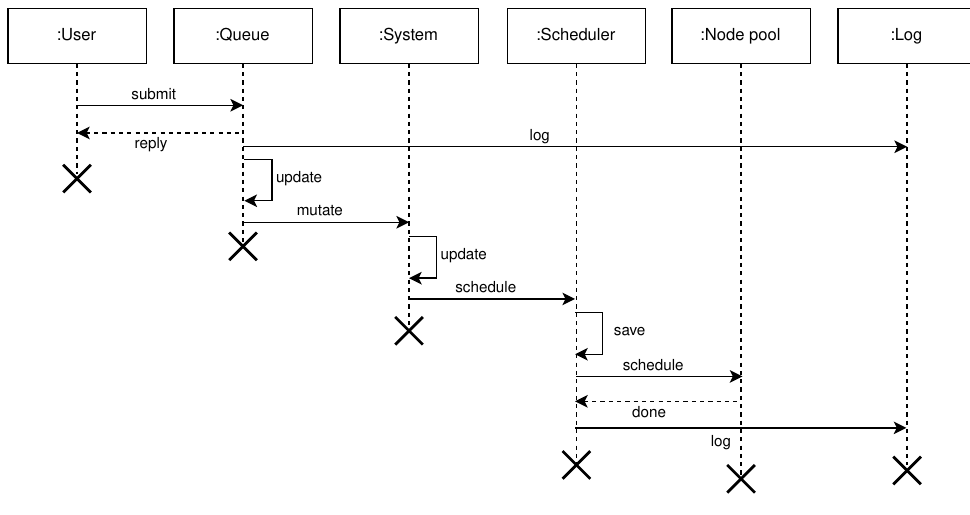
Figure 7. High level mutate operation diagram.